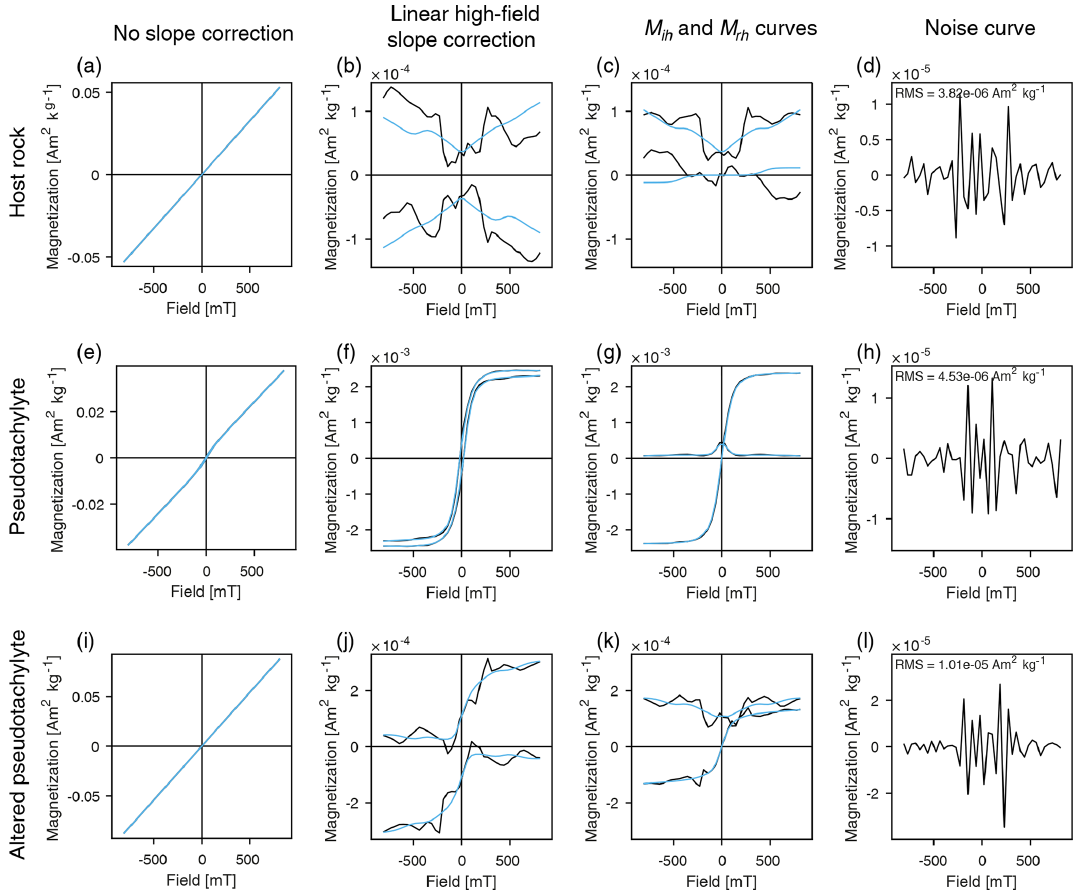
Figure 11. Hysteresis results for selected host rock, pseudotachylyte and altered pseudotachylyte specimens. Dominant paramagnetic behav- iors of all samples are displayed in raw measurement curves (left column). Panels (a) , (e) and (i) show the raw hysteresis loop corrected for the sample mass. Panels (b) , (f) and (g) show the hysteresis curve after slope correction. Panels (c) , (g) and (k) show the induced hysteresis curve (Mih) and remanence hysteresis curve (Mrh). Panels (d) , (h) and (l) show the noise curve of the respective host rock, pseudotachylyte and altered pseudotachylyte, which have been slope corrected for the paramagnetic signal contribution. Processing of hysteresis loops was done with the HystLab software by Paterson et al. (2018).